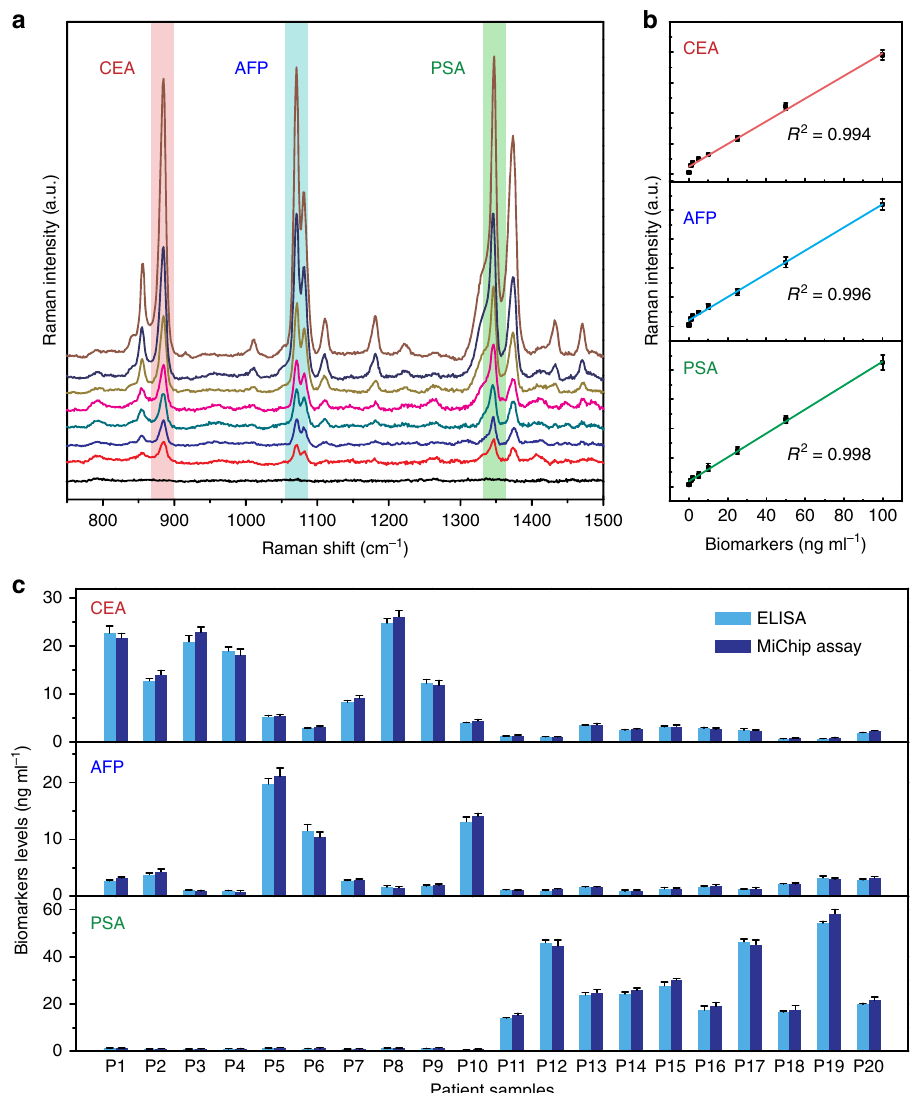
Fig. 4 The MiChip assay of protein biomarkers in serum specimens. a SERS responses to a mixture biomarkers (PSA:AFP:CEA = 1:1:1, ranging from 0 to 100 ng ml − 1 ) spiked in arti fi cial serum samples. b Standard curves for the multiplexed quantitative analysis were generated by plotting the SERS peak intensity at 1341, 1071, and 885 cm − 1 against the concentrations of PSA, AFP, and CEA, respectively. c The levels of the three biomarkers in the 20 clinical specimens measured by the MiChip assay and ELISA. The error bars in b and c stand for s.d. of triplicate